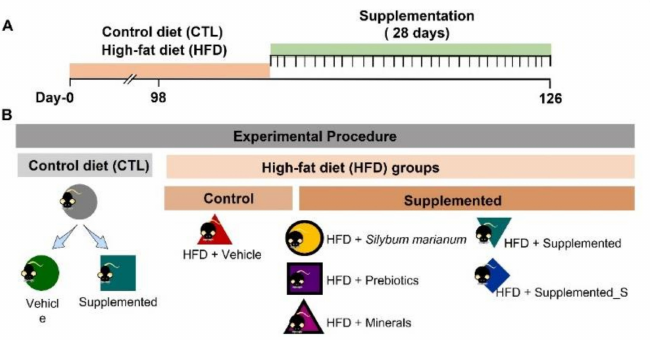
Figure 1. Schematic outline of the experimental procedure and supplementation time, common to all animals. ( A ) Timeline; ( B ) experimental